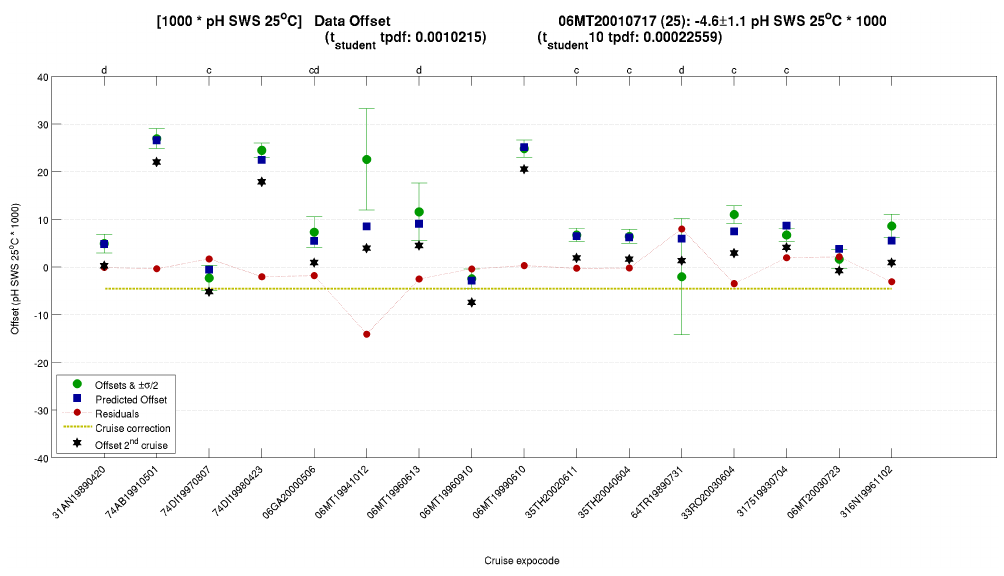
Figure 7. Cruise crossover information plot for 06MT20010717 (25).